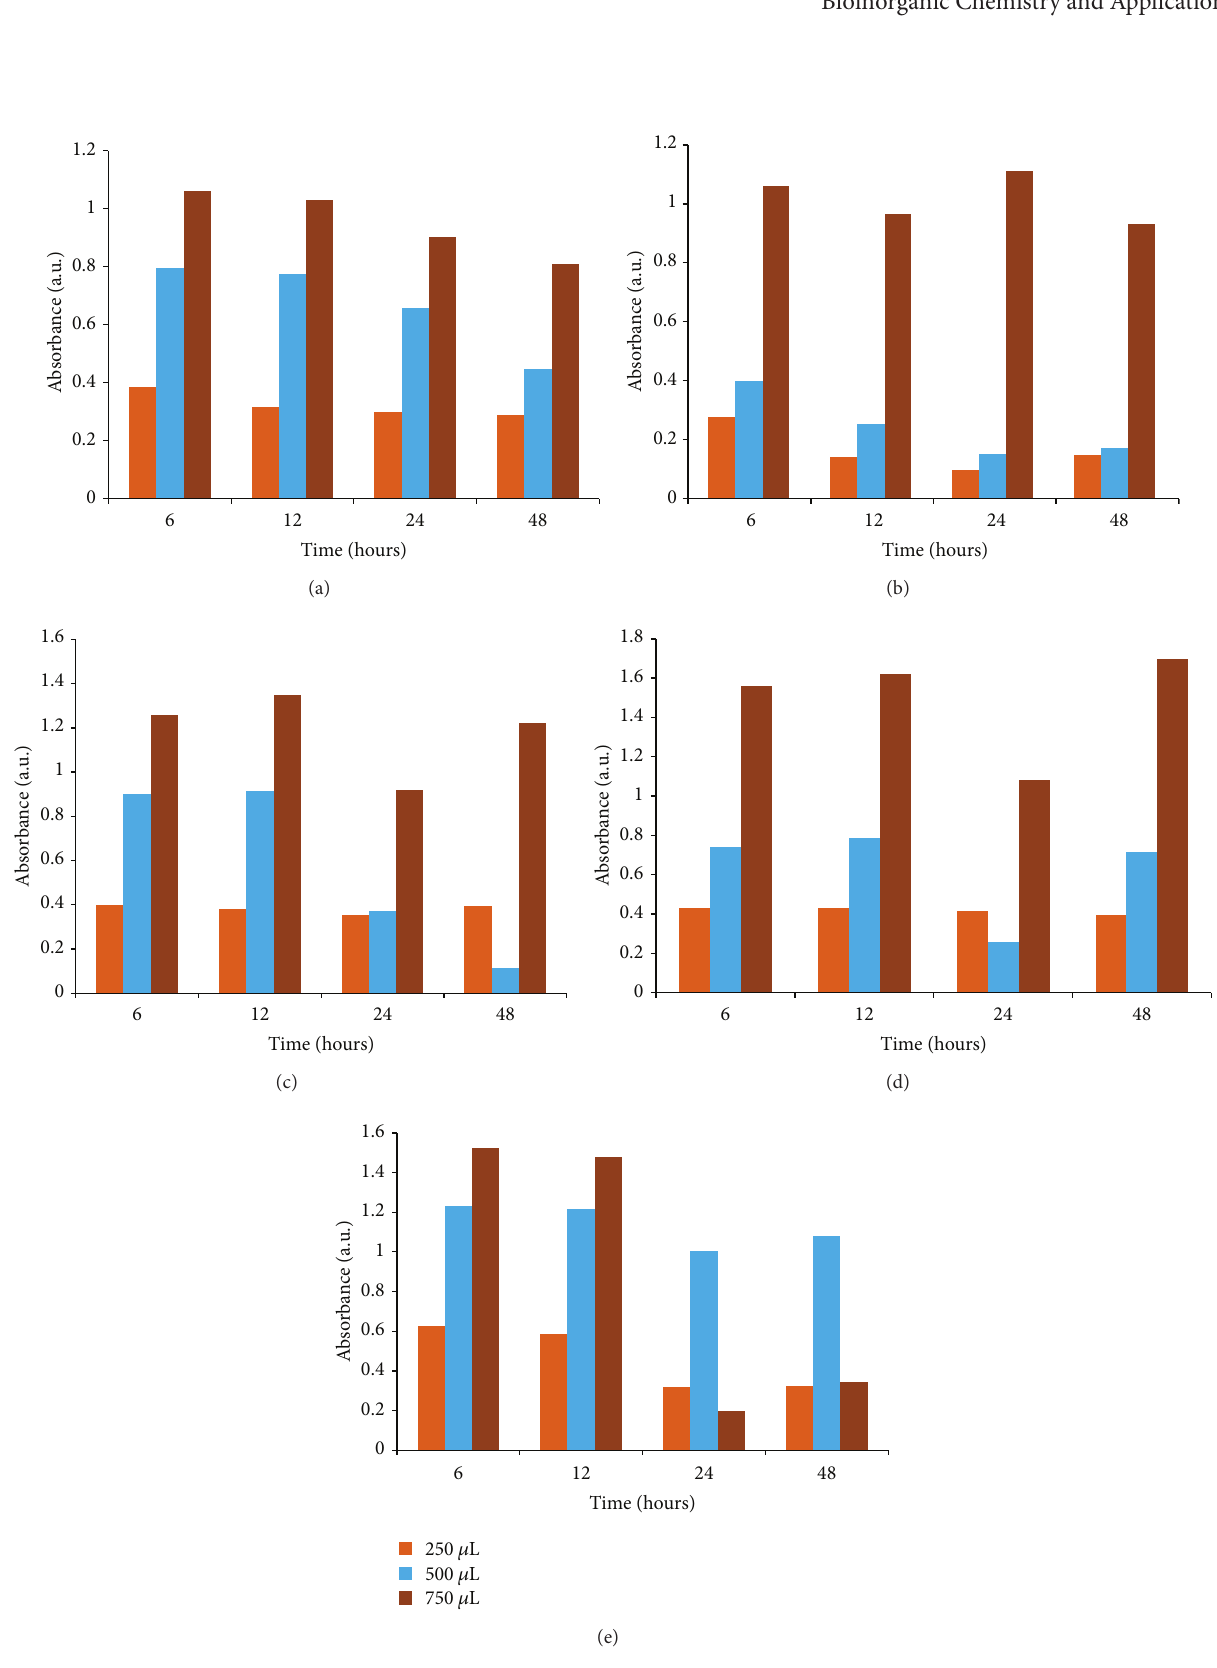
Figure 9: Antibacterial activity of silver nanoparticles by broth dilution method: (a) B. subtilis, (b) K. planticola , (c) K. pneumoniae, (d) S. nematodiphila, and (e) E. coli